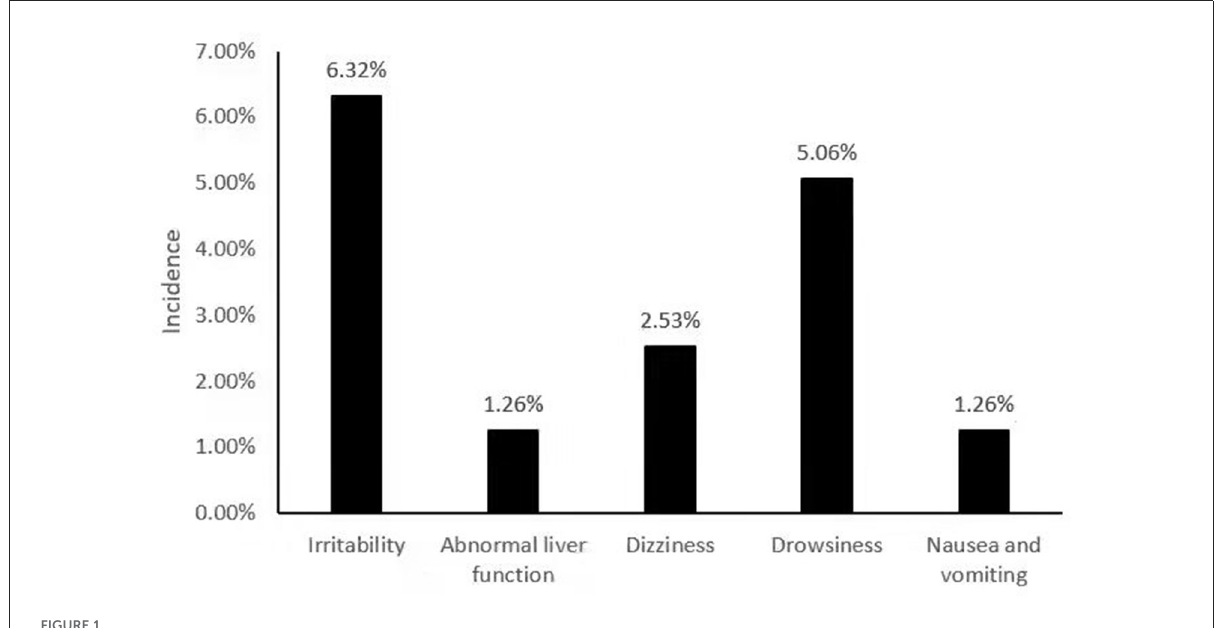
FIGURE1 Perampanel adverse reaction